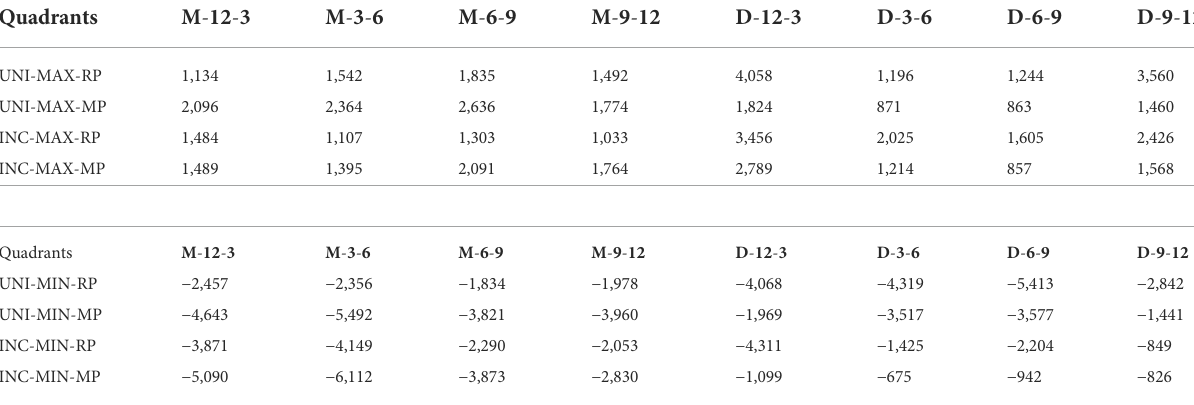
TABLE 3 Averages of Maximum (MAX) and Minimum (MIN) principal strains for reconstruction plate (RP) and miniplate (MP) fi xation in biting tasks unilateral(UNI)andincisal(INC)bitingacrossclock-orientedquadrantsinthemesial(M)anddistal(D)healingsite.M-12-3,M-3-6,M-6-9,andM- 9-12 arethe four quadrants in the mesial side with a clockwise annotation. D-12-3, D-3-6, D-6-9, and D-9-12 arethe four quadrants in the distal side with a clockwise annotation. All values are given in